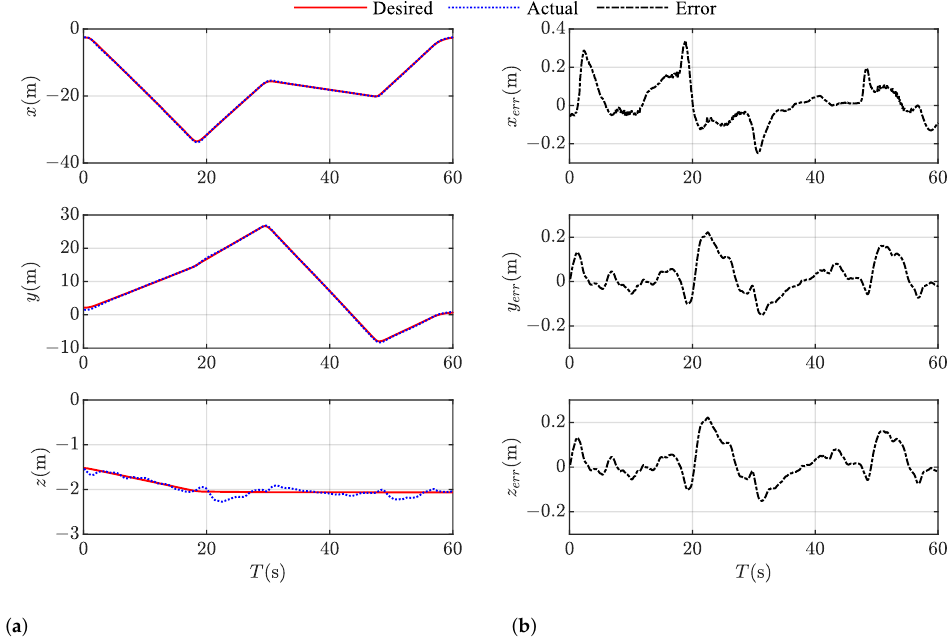
Figure 20. Position tracking during flight: ( a ) position tracking response; ( b ) position tracking